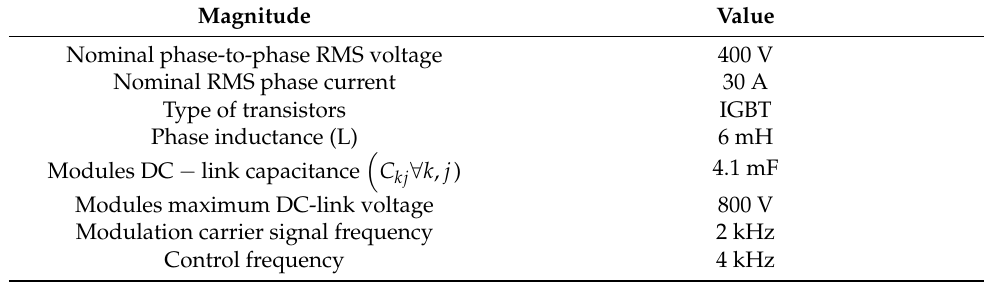
Figure 2. One individual module ( a ) and the whole converter ( b ) where the tests were run. Table 1. Converter